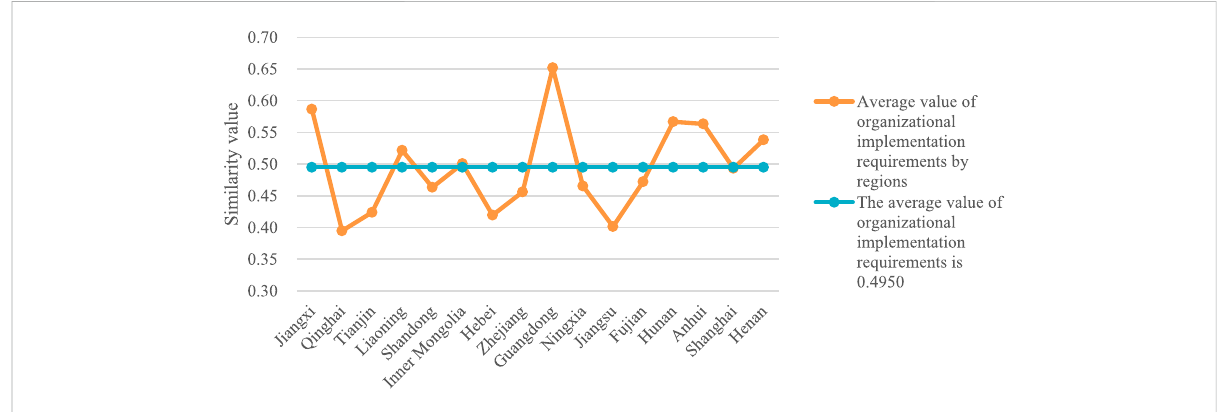
FIGURE 6 Average similarity of implementation requirements of different regions.